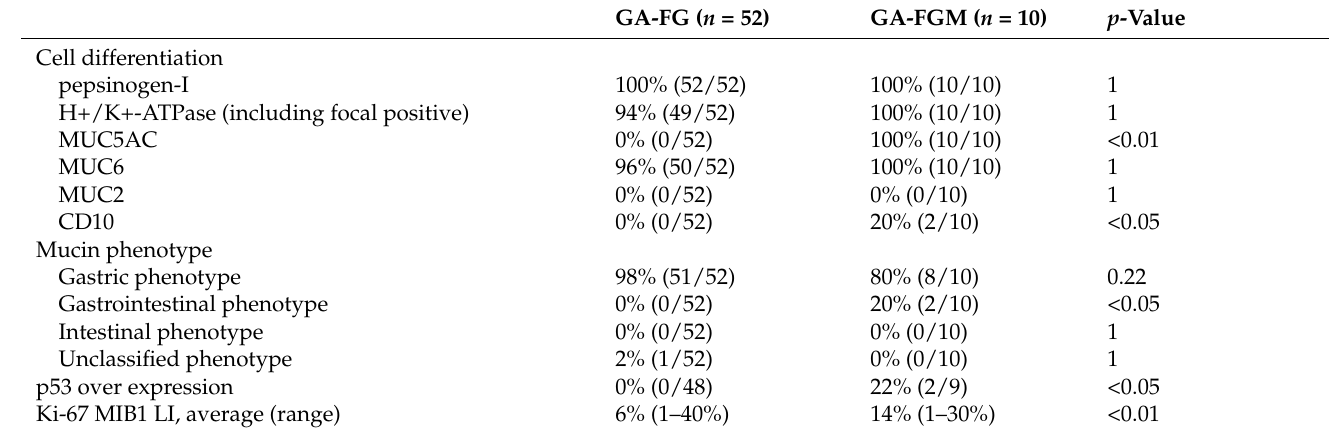
Table 4. Immunohistochemical features of